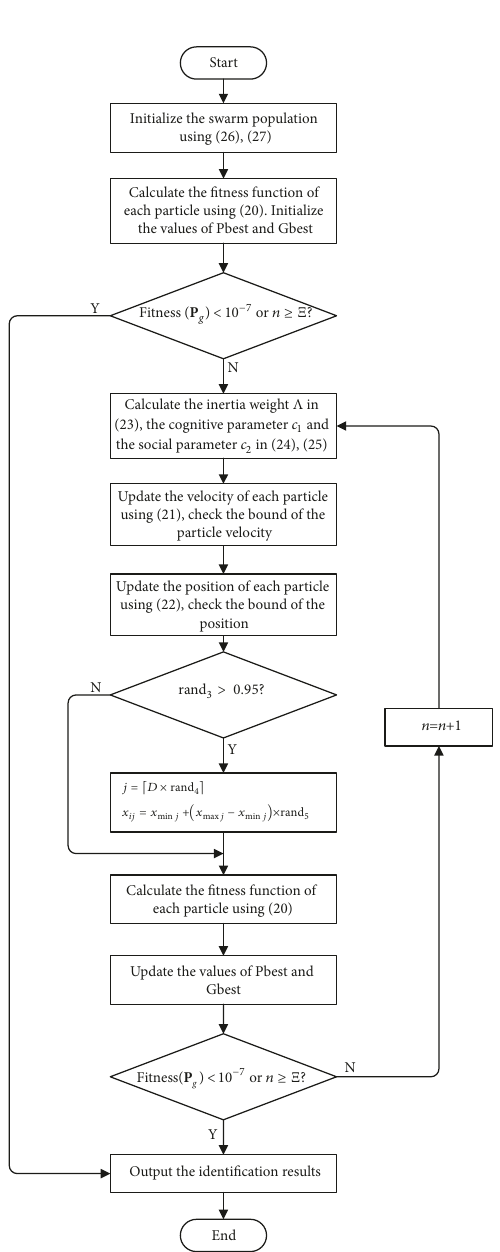
Figure 4: The flowchart of the modified PSO